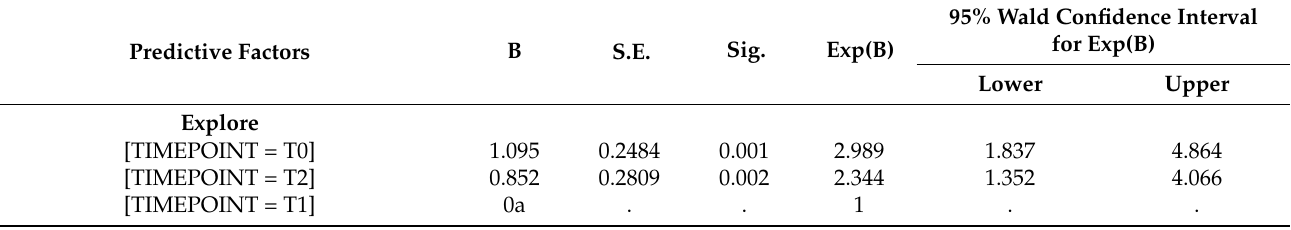
Table 5. Generalized linear model predicting changes in dog behavior